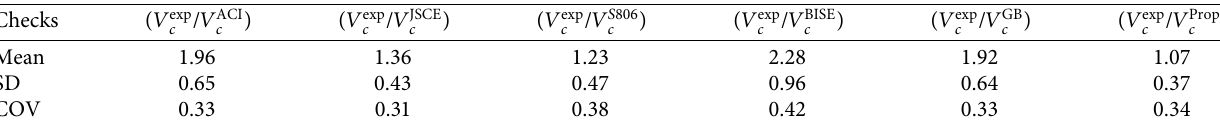
V exp c with c . V pred ) c / c